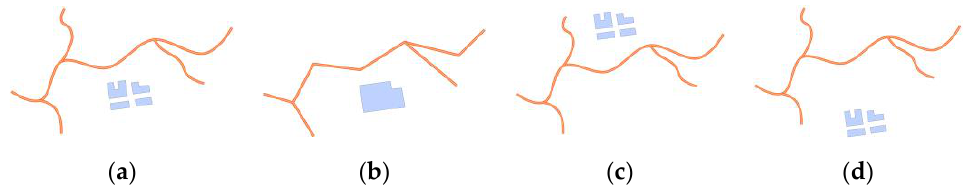
Figure 2. Factors affecting micro scenes in similarity judgements: ( a ) original object group; ( b ) shape transformation; ( c ) direction transformation; ( d ) position transformation.